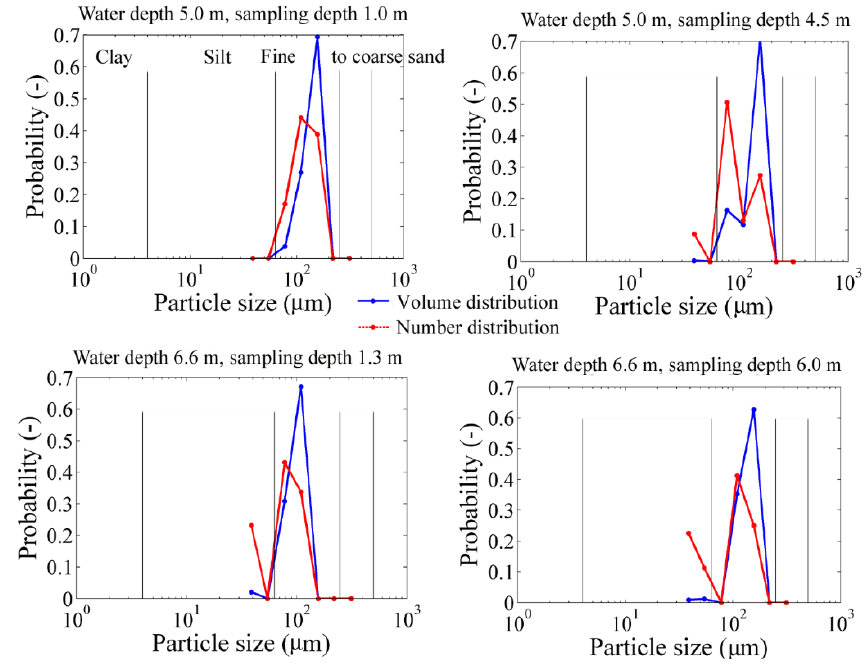
Figure 6. Subset of four PSDs from analysis of sediment suspended from the riverbed: samples in two verticals with different depths in the secondary reach Colastiné of the Parana system.